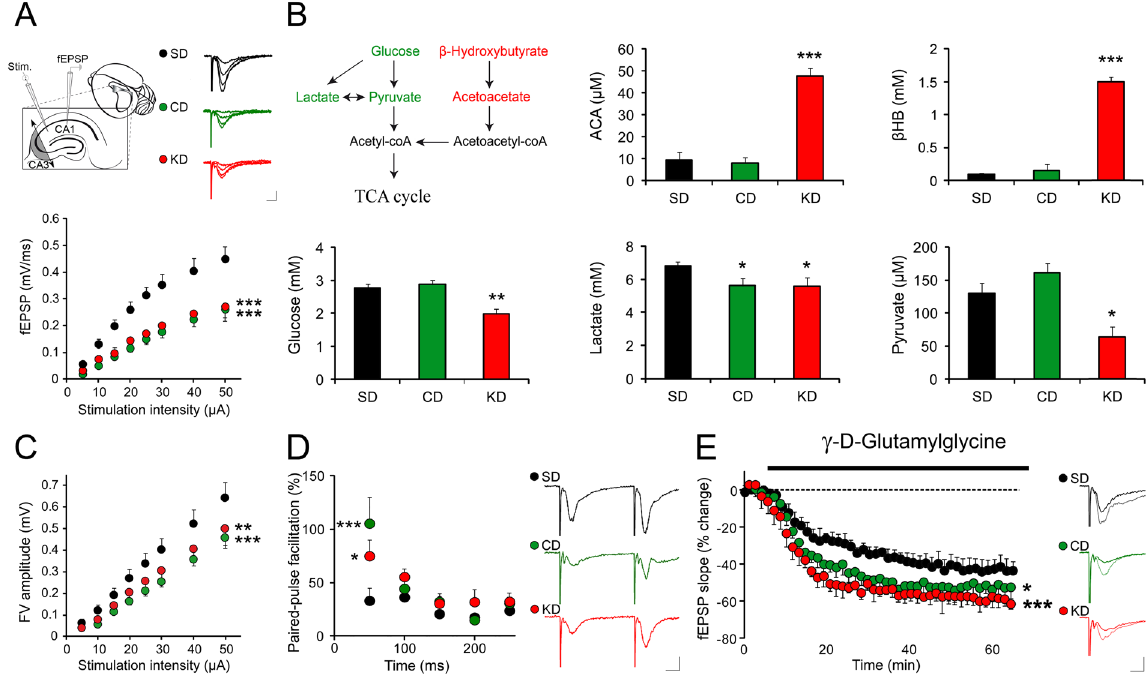
Figure 2. CD treatment reduces excitatory synaptic transmission. (A ) Hippocampal slices prepared from mice fed with KD or CD displayed reduced basal synaptic transmission compared to control SD fed animals (SD controls, n = 14; CD, n = 7; KD, n = 6; p < 0.001). Calibration bars: 10 ms, 0.5 mV. ( B ) Analysis of blood ketone bodies concentrations revealed a significant increase in both β -hydroxybutyrate ( β HB; p < 0.001) and acetoacetate (ACA; p < 0.001) in the KD group only (n = 10). Markers of glycolysis (glucose, p < 0.01; lactate, p < 0.05; pyruvate, p < 0.05) were also significantly reduced in mice supplied with KD, indicating that this diet only induces high level of ketosis. The only change triggered by CD was a significant reduction in lactate (p < 0.05). ( C ) Analysis of the fibre volley amplitude as a function of stimulation intensity revealed a significant reduction in presynaptic excitability of CD and KD fed mice as compared to controls fed SD (CD: p < 0.001, KD: p < 0.01). ( D) CD and KD dietary treatment also resulted in a clear enhancement of paired- pulse facilitation (SD, n = 5; KD, n = 6, p < 0.05; CD, n = 7, p < 0.001), which indicates a decreased probability of release. Example traces show facilitation at 50 ms ISI. Calibration bars: 10 ms, 0.5 mV. ( E) The low-affinity competitive antagonist γ -d-glutamylglycine ( γ -DGG), at a non-saturating concentration (0.5 mM) at which its potency depends on glutamate concentration decreased neurotransmission to a greater extent in CD and KD fed mice compared to SD controls (SD, n = 9; KD, n = 6, p < 0.001; CD, n = 7, p < 0.05), indicating lower glutamate synaptic concentrations in the KD and CD groups. Calibration bars: 10 ms, 0.5 mV. * p < 0.05, ** p < 0.01, *** p <